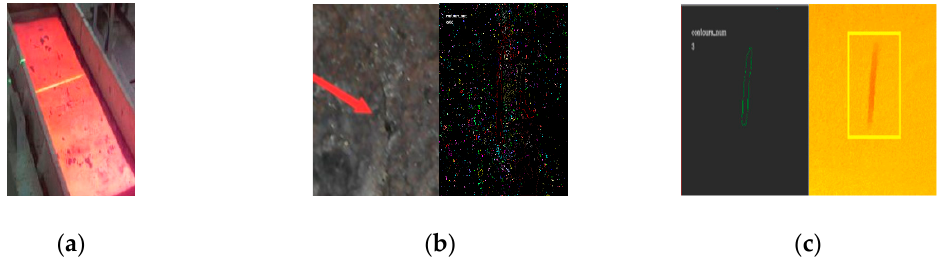
Figure 11. Searching for ROI in optical image and laser scanning (depth) image in 3D-LDS. ( a ) CCD image (Object depth:3mm); ( b ) Searching results for ROI; ( c ) Laser scanning image and search results for ROI.